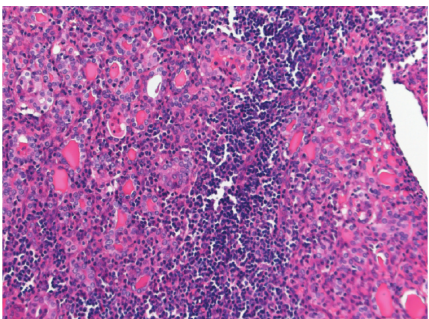
Figure 1: Di ff use hyperplasia with prominent uncomplicated hyperplastic nodes and some lymphocytic thyroiditis (Hematoxy- lin-eosin, ×